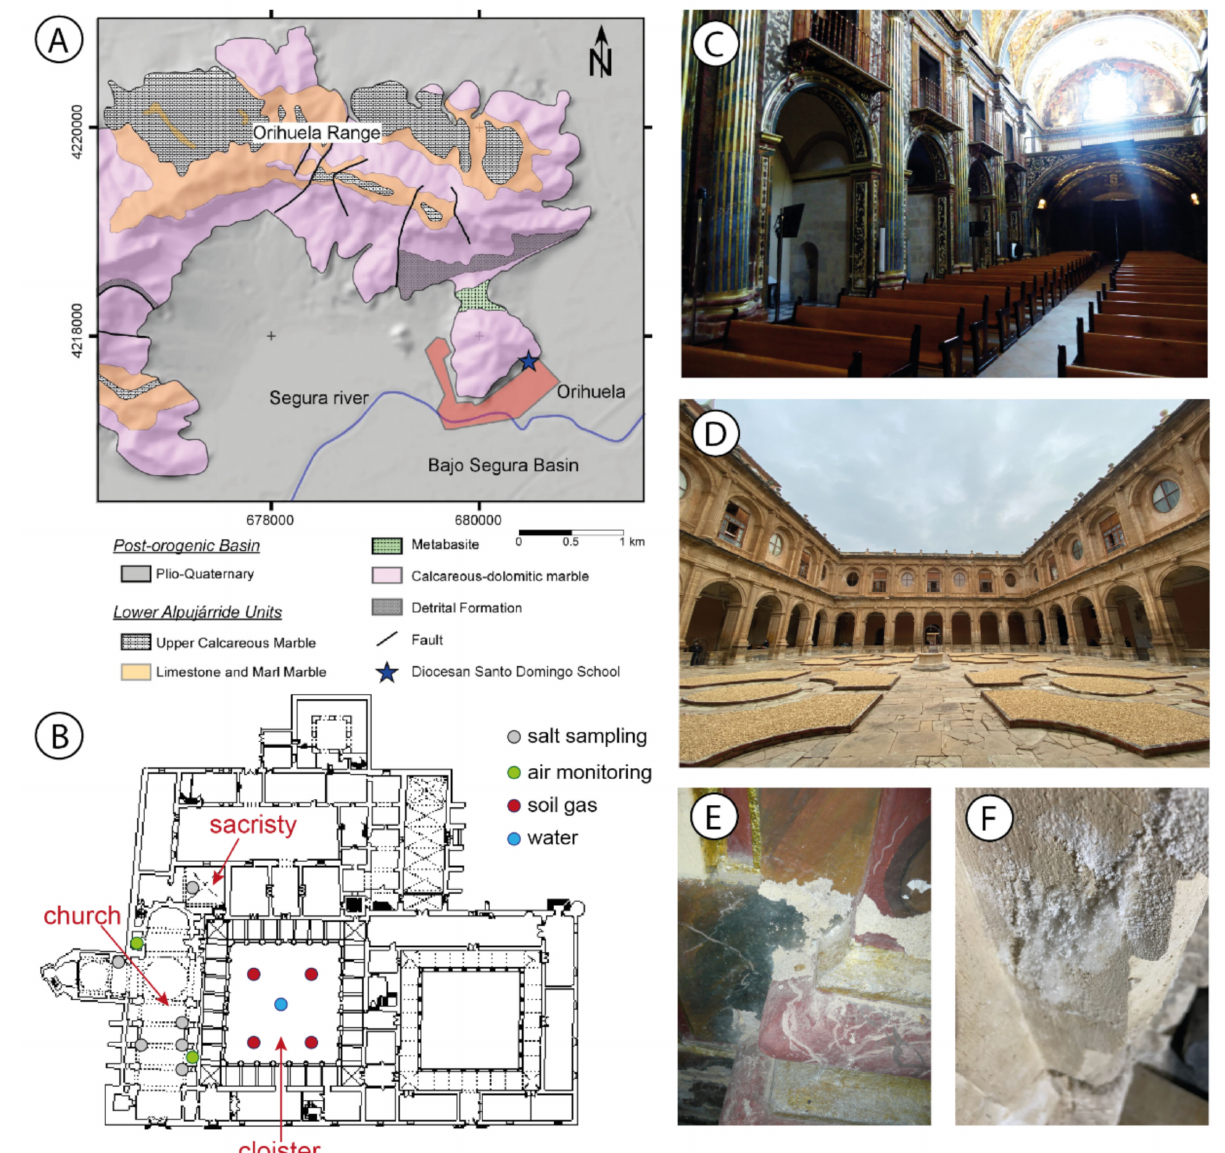
Figure 1. ( A ) Geological map of the eastern sector of Orihuela Range and Bajo Segura basin (modified after [24,25]). ( B ) Location of air monitoring and salt, soil gas and water sampling in the Diocesan Santo Domingo School. View of the ( C ) church and ( D ) cloister. Examples of deterioration patterns due to salt crystallization: ( E ) material loss (scaling and granular disintegration), and ( F ) surface modifications (efflorescences, crust and